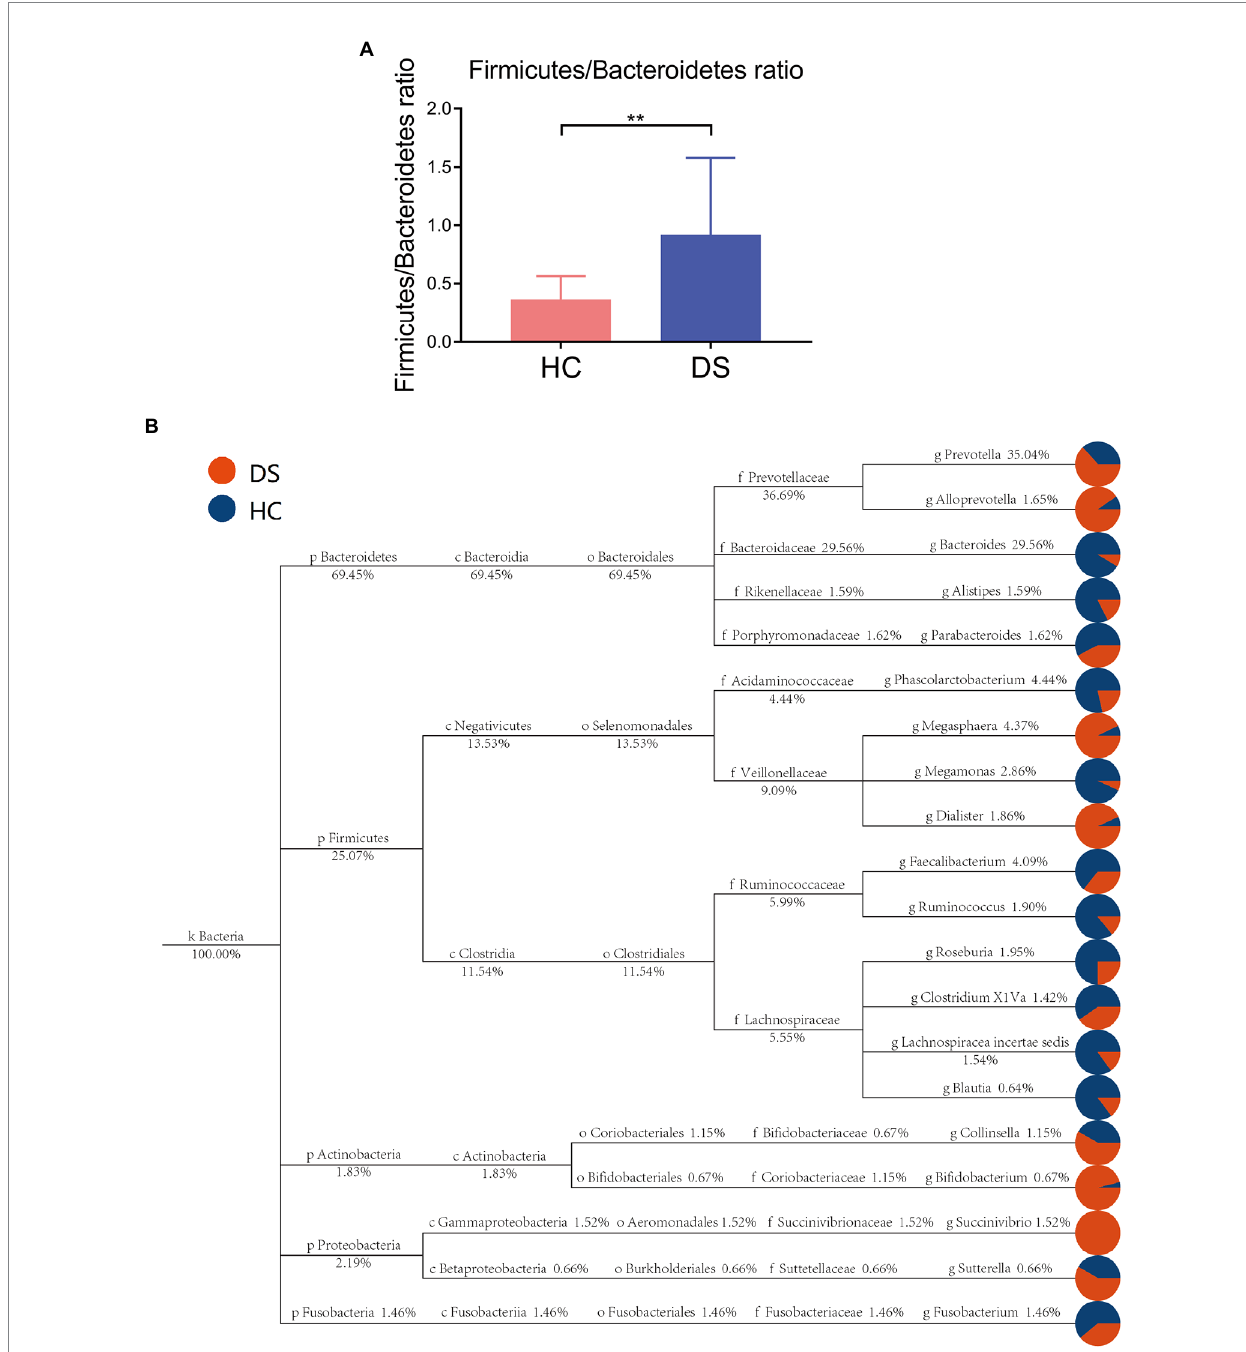
FIGURE 3 Taxon-based analysis of the microbiome in the DS and non-DS groups. (A) A significant difference was observed (** p < 0.01) in the ratio of Firmicutes and Bacteroidetes in the intestinal microbiota of the non-DS and DS groups. (B) The classification and abundance of intestinal microbiota from individuals with DS and non-DS volunteers. Different colors represent classification levels, and the size of the circle represents the relative abundance of the classification. The number below the taxonomic name indicates the relative percentage abundance. HC, non-DS volunteers (or non-DS group); DS, individuals with DS (or DS